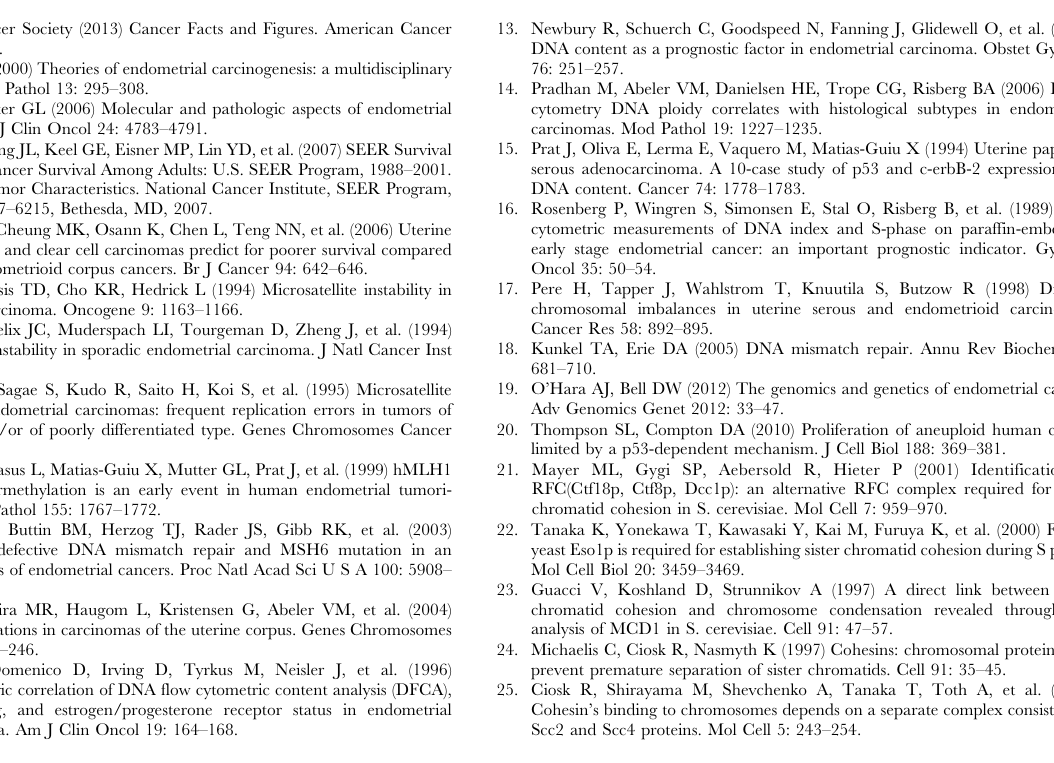
Table S1 RT-PCR primers used to assess the expres- sion of 21 candidate human chromosomal instability genes. (XLSX) Table S2 PCR primers used to amplify 21 candidate human chromosomal instability genes within the dis- covery screen. Table S3 PCR primers used to amplify and sequence CHTF18, ESCO1, and MRE11A within the validation screen. Table S4 Status of microsatellite instability, MSH6 , ESCO1 , CHTF18 , MRE11A , and ATAD5 for the 107 endometrial tumors in this study. Table S5 Frequency of somatic mutations in the ESCO1 , CHTF18 , MRE11A , and ATAD5 cohesion genes in 105 endometrial tumors, according to microsatellite insta- bility and MSH6